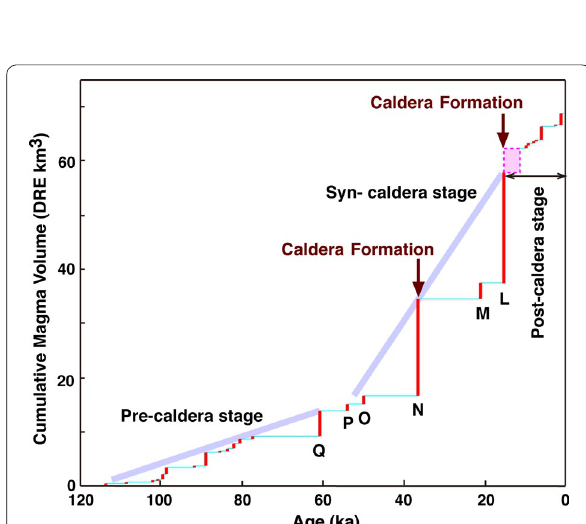
Fig. 11 Cumulative magma volume erupted from Towada Volcano. A red solid line represents an eruption event. A lilac solid line shows a tendency of the eruption rate. A pink square shows the ranges of vol- ume and age for a volcanic edifice which is undivided into separate eruption events. L to Q is the name of eruption episode (Hayakawa 1985). The caldera-forming Episodes L and N produced the Hachi- nohe and Ofudo Ignimbrites, respectively. This step diagram was made from Hayakawa (1985), Nakagawa et al. (1986), Yamamoto (2015) and Kudo (unpublished data). Hayakawa (1985) defined the syn-caldera stage as the period from episode Q to L. This paper regards the Episode Q as the last eruptive event in the pre-caldera stage from its geochemical feature